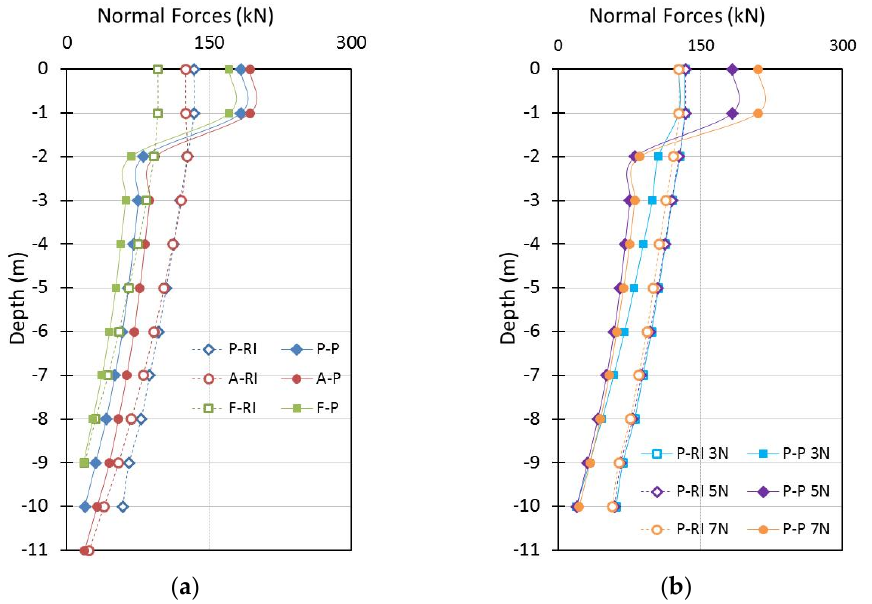
Figure 13. Normal forces in the rigid inclusion and pile systems with different support conditions. ( a ) 5-storey Building; ( b ) 3-, 5- and 7-storey Buildings.